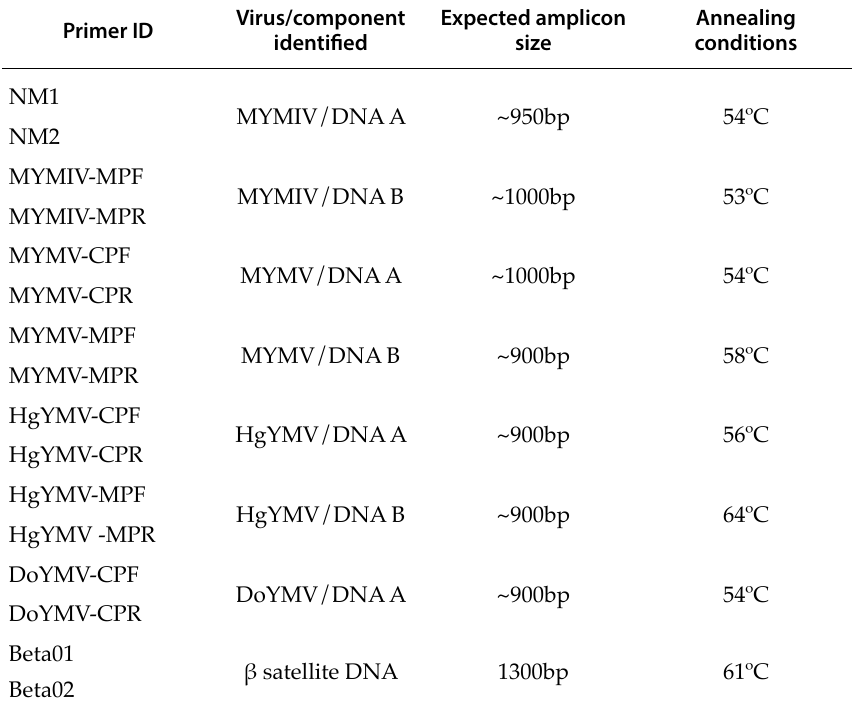
Table 1. Details of the primers used for the detection of viruses causing yellow mosaic disease (Briddon et al., 2002; Naimud - din and Akram,